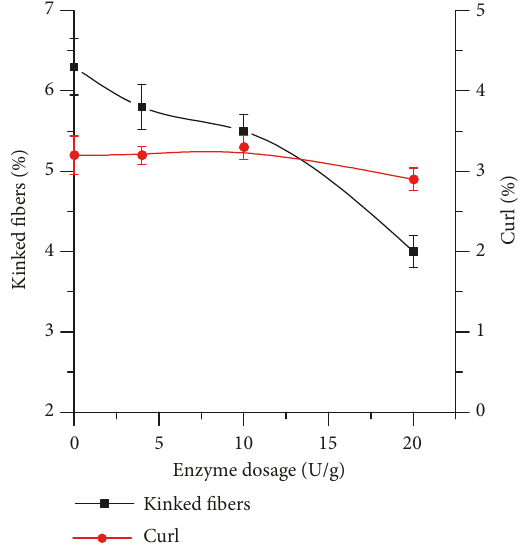
Figure 8: Effect of xylanase pretreatment on the fiber kinks and curls.